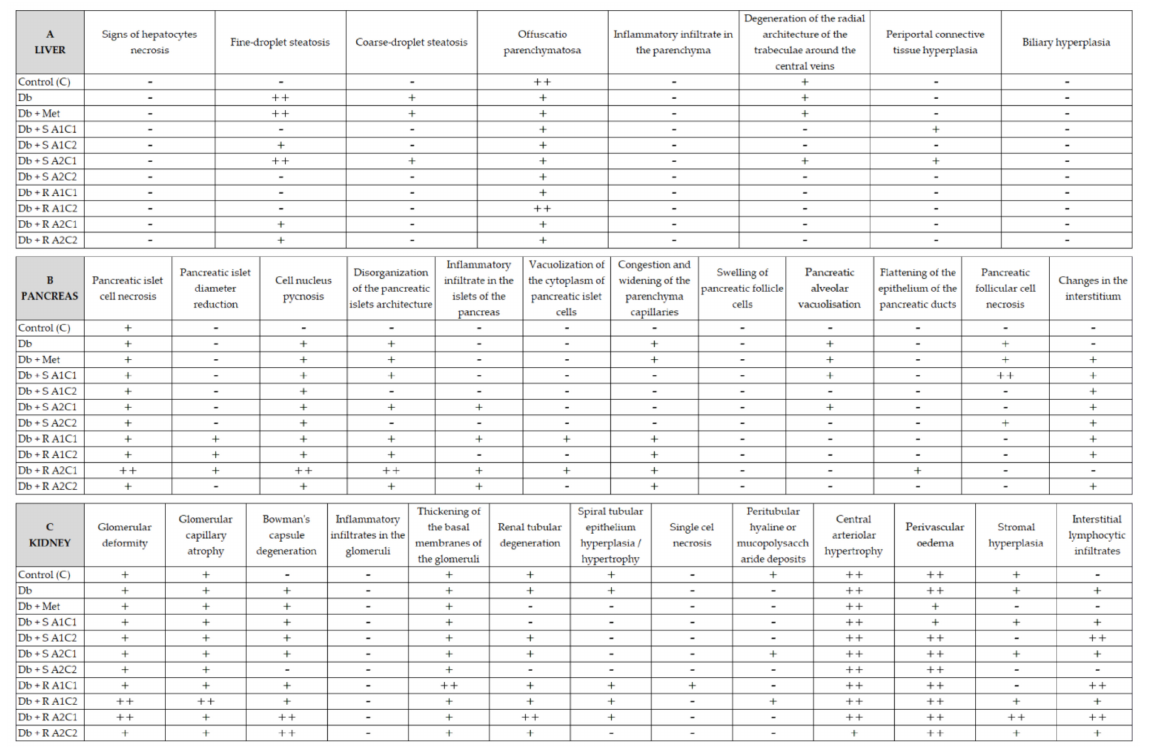
Figure 3. Effects of the diet and SG, L-arg, and Cr(III) supplementation on histological alterations in organs of rats: ( A ) liver, ( B ) pancreas, and ( C ) kidneys. Symbols indicate the severity of the